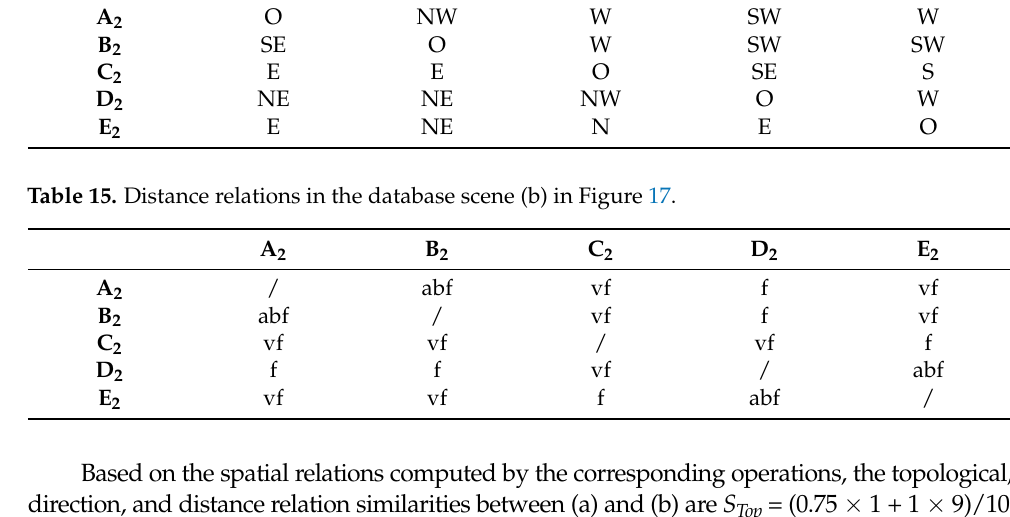
Table 13. Topological relations in the database scene (b) in Figure 17. A 2 B 2 ss-equal ss-touch ss-disjoint ss-disjoint ss-disjoint ss-touch ss-equal ss-disjoint ss-disjoint ss-disjoint ss-disjoint ss-disjoint ss-equal ss-disjoint ss-disjoint ss-disjoint ss-disjoint ss-disjoint ss-equal ss-disjoint ss-disjoint ss-disjoint ss-disjoint ss-disjoint ss-equal Table 14. Direction relations in the database scene (b) in Figure 17. A 2 B 2